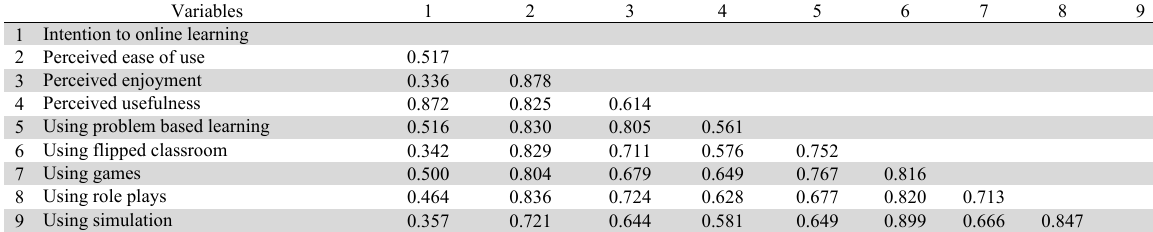
Heterotrait-Monotrait (HTMT) Ratio Variables